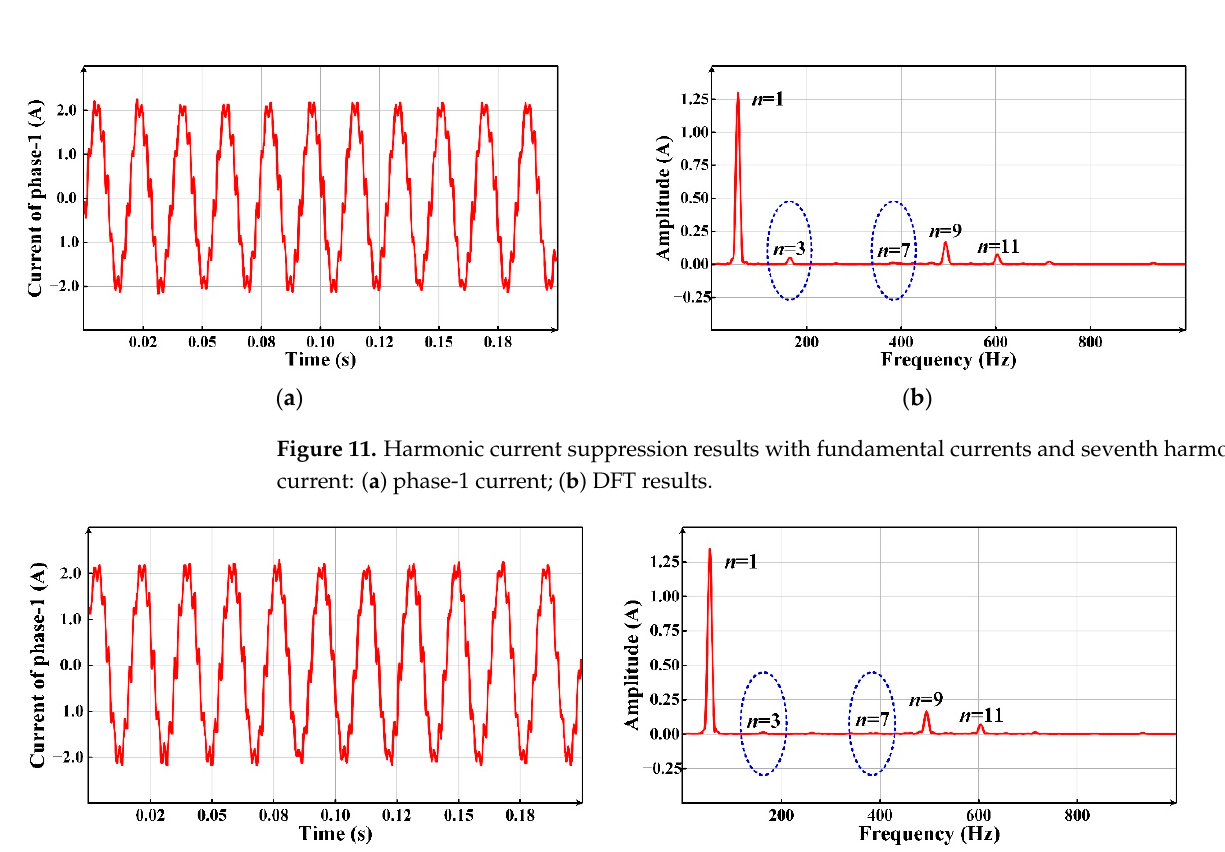
Figure 10. Harmonic current suppression results with fundamental currents and third harmonic current: ( a ) phase-1 current; ( b ) DFT results.